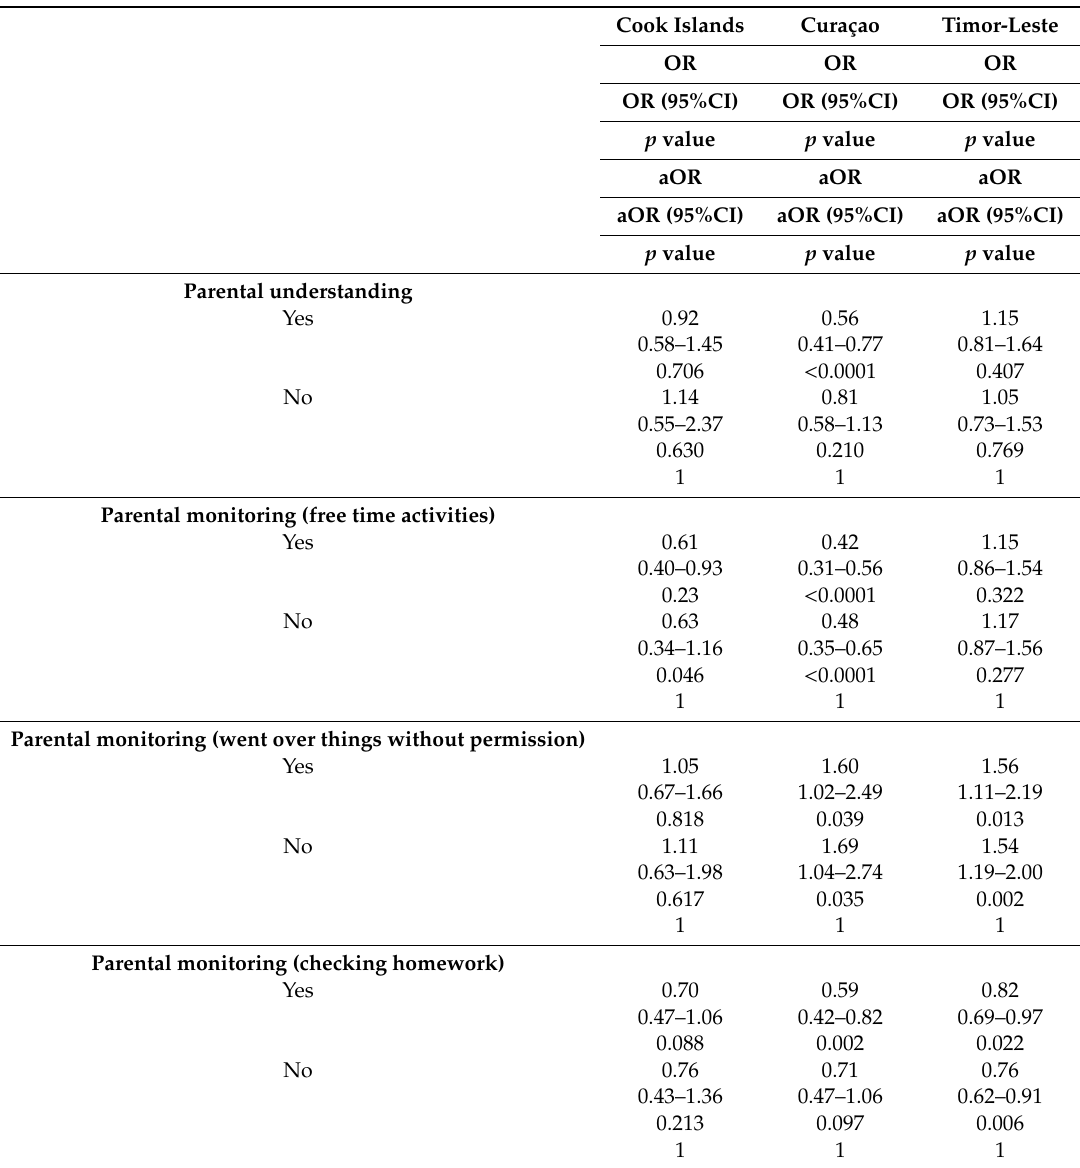
Table 3. Multivariate analysis of current tobacco use and parental monitoring activities among school attending adolescents.